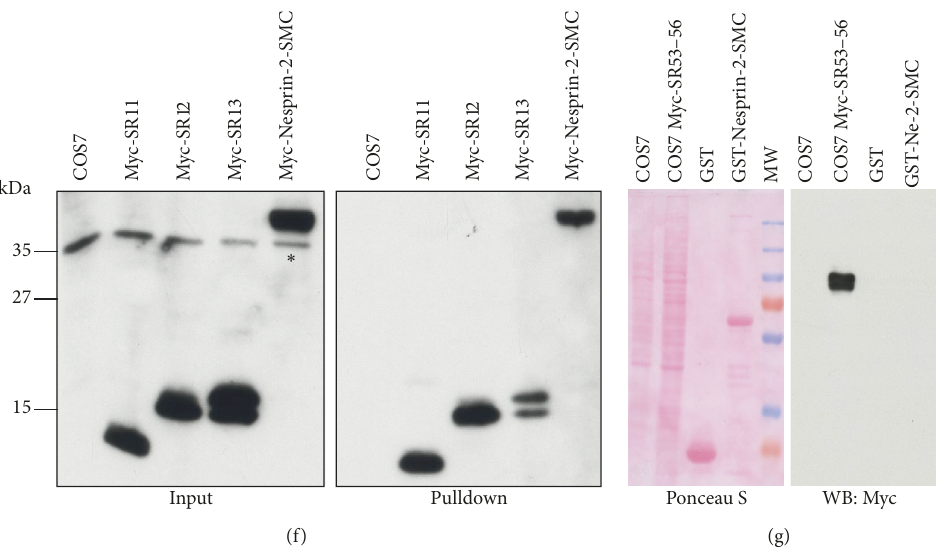
Ponceau S WB: Myc (f) Figure 1: Characterization of the SMC domain of Nesprin-2. (a) Schematic of Nesprin-2 (not drawn to scale). The location of the SMC domain (spectrin repeats 11–13) and the C-terminal spectrin repeats (53–56) is shown. Epitopes of antibodies used are indicated above the schematic. ABD, actin binding domain; ovals, spectrin repeats. The spectrin repeat domain starts at position 308. (b) Sequence comparison of the Nesprin-2-SMC domain with coiled-coil regions of SMC2 and SMC4. The sequence comparison was performed using LALIGN, the Pairwise Sequence Alignment tool from EMBL-EBI (https://www.ebi.ac.uk/Tools/psa/lalign/). Nesprin-2 (NCBI GenBank accession number AF435011.1), SMC2 (NCBI GenBank accession number O95347.2), and SMC4 (NCBI GenBank accession number Q8WXH0.3) were used. :, identical amino acid; ., conservative substitution. (c) Analysis of Nesprin-2-SMC by gel filtration chromatography. UV traces of the elution profile are shown. Nesprin-2 SMC (calculated molecular weight 39 kDa). Molecular weight markers were ovalbumin (43 kDa), conalbumin (75 kDa), and aldolase (158kDa). (d) Analysis of chemically crosslinked Nesprin-2-SMC. Zero-length cross-linking reagent EDC (1-ethyl-3- [3-dimethylaminopropyl] carbodiimide hydrochloride) was used at decreasing concentrations. The proteins were separated by SDS-PAGE (10% acrylamide) and stained with Coomassie Blue. (e) Schematic representation of Myc-tagged Nesprin-2-SMC polypeptides. Amino acid positions refer to human Nesprin-2 giant (accession number AF435011.1). (f) Interaction of GST-Nesprin-2-SMC with individual Myc-tagged spectrin repeats derived from Nesprin-2-SMC and expressed in COS7 cells. GST-Nesprin-2-SMC was used for pulldown (right panel). Western blots were probed with mAb 9E10 specific for Myc. Asterisk, endogenous Myc [25]. (g) Specificity of the Nesprin-2-SMC interaction. Myc-SR53–56expressedinCOS7cellswasusedforpulldownswithGSTforcontrolandGST-Nesprin-2-SMC.COS7andCOS7Myc-SR53–56 represent whole cell lysates. The Ponceau S stained blot and the corresponding blot probed with mAb 9E10 are shown. MW, molecular weight marker (from top to bottom: 200, 130, 100, 70, 55, 35, and 25